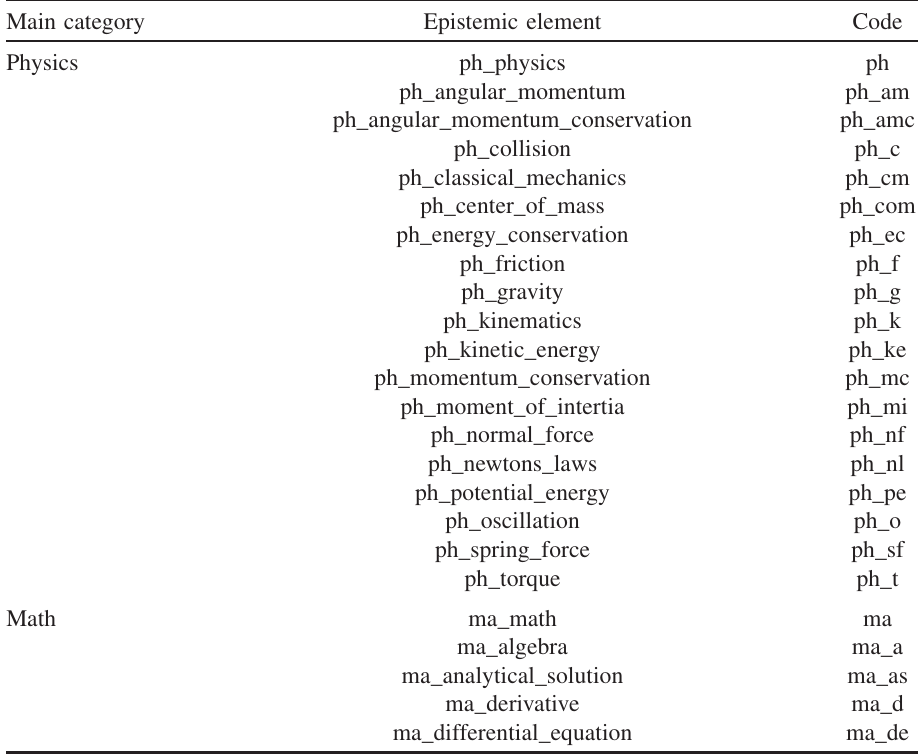
TABLE III. Coding scheme used for coding transcribed interviews with students into epis- temic